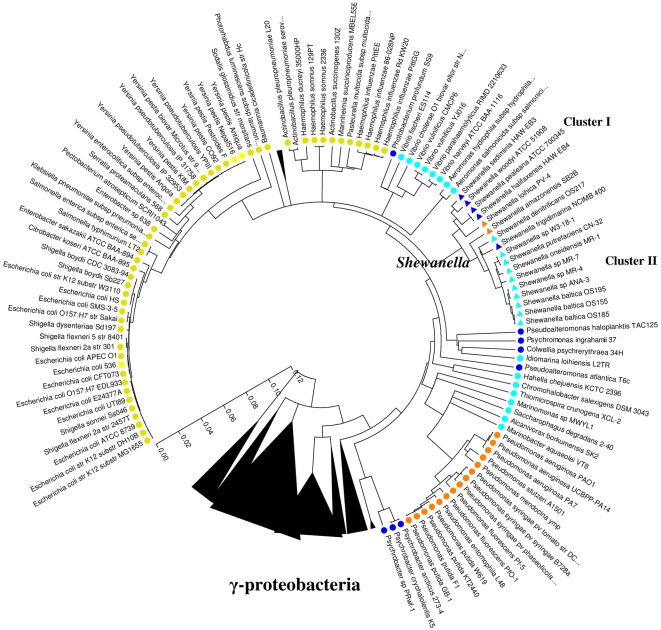
Phylogenetic analysis of the complete 16S rDNA sequences of γ-proteobacteria.Only the 110 strains compared for their genomes were listed. Yellow (coliforms) and orange (soil Pseudomonas) colors indicate bacteria living in warmer environments. Blue colors indicate γ-proteobacteria living in colder marine/aquatic environments. Two 42°C -tolerant Shewanella are indicated by orange triangles. The dark blue colors indicate bacteria adapted to deep cold sea and polar environment. The phylogenetic tree was generated based on pair-wise nucleotide distance of Kimura two-parameter using the neighbour-joining method (complete deletion, 3000 bootstrap value) included in the MEGA3 software package [68].